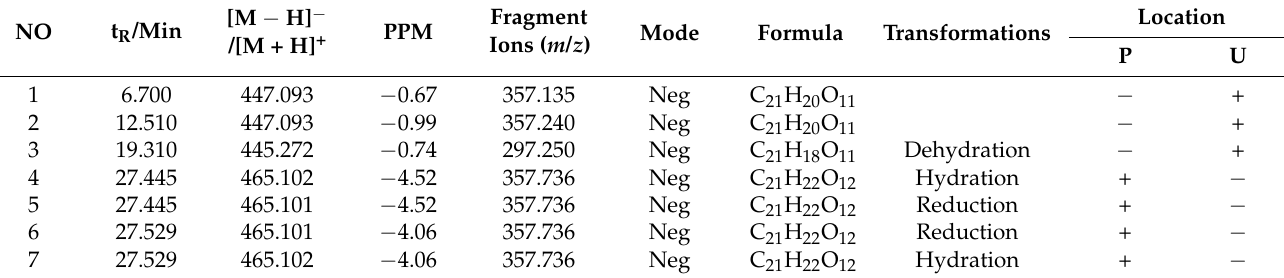
Table 4. Identification of metabolites of orientin in plasma and